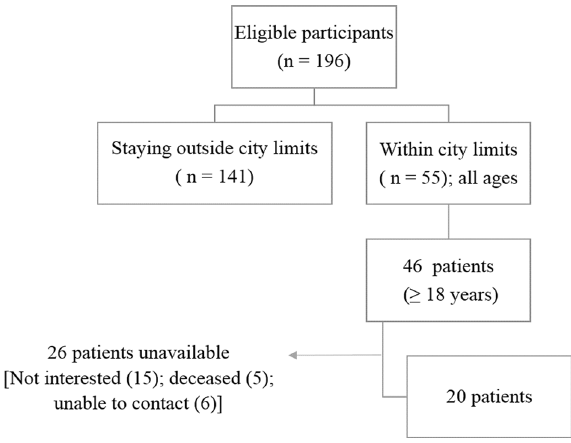
Figure 1. Flowchart showing recruitment process in the